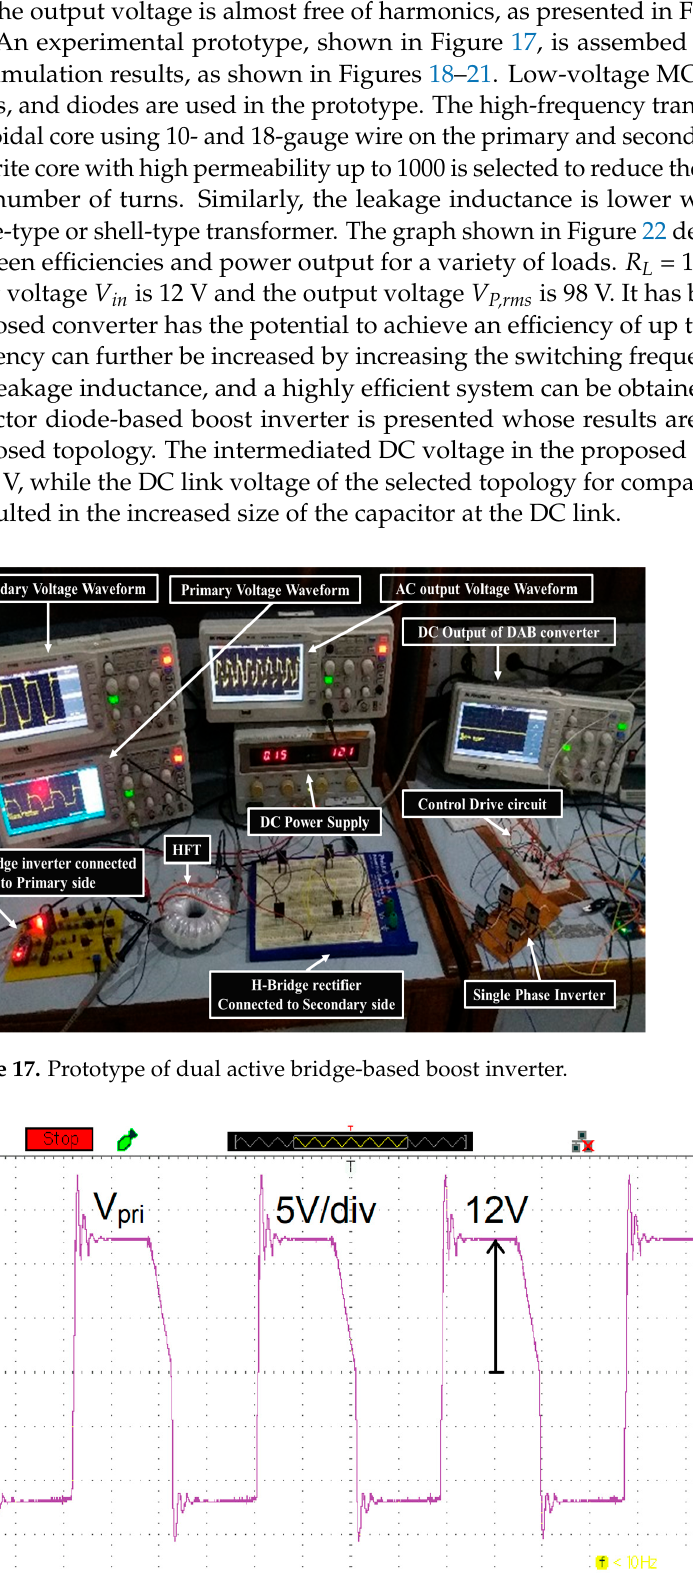
Figure 18. Output voltage of H-bridge and input to high-frequency transformer.